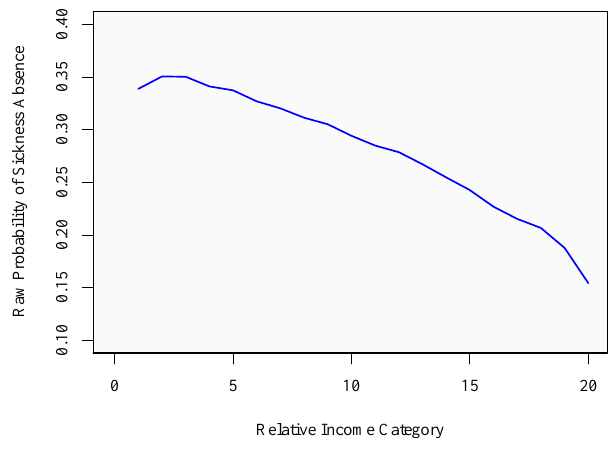
Figure 1. Relative income and sickness absence.